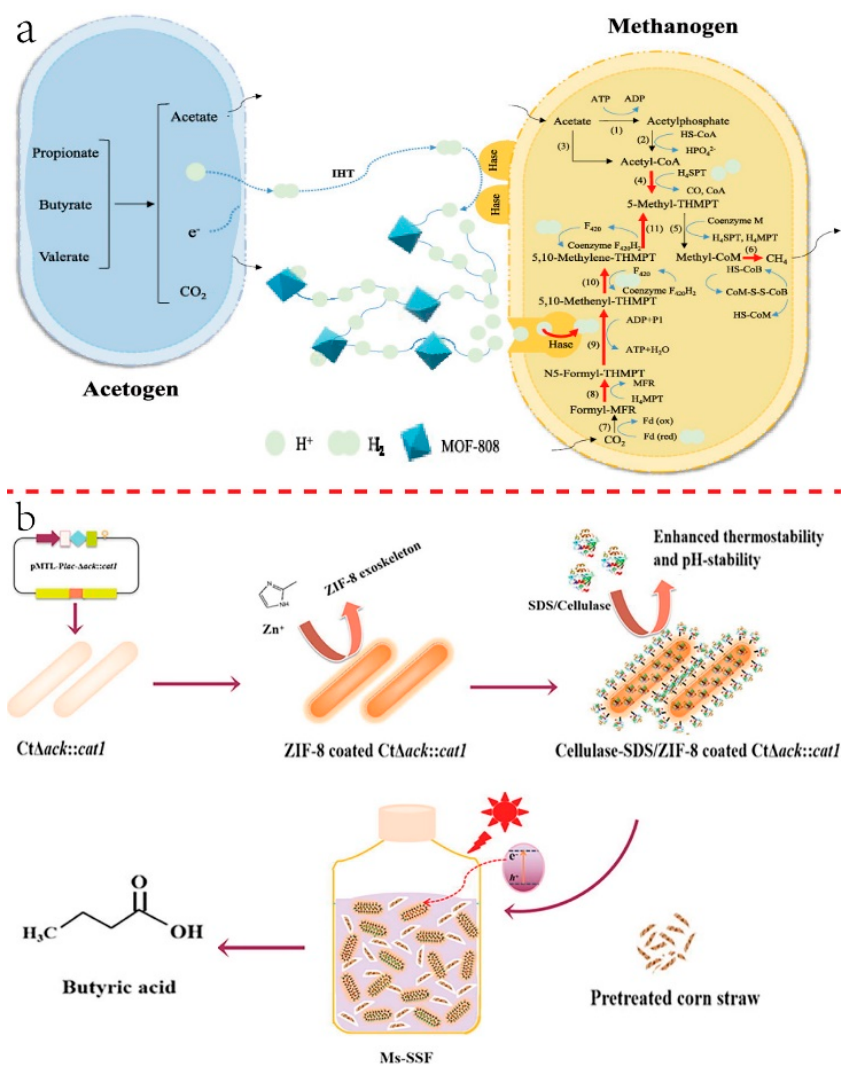
Figure 4. ( a ) Schematic illustration MOF-808 facilitating IET [63]. Copyright 2022, American Chemical Society. ( b ) MOFs served as a photocatalyst and protective exoskeleton for cellulase in the hydrolysis of rice straw and butyric fermentation system [66]. Copyright 2021, Elsevier.